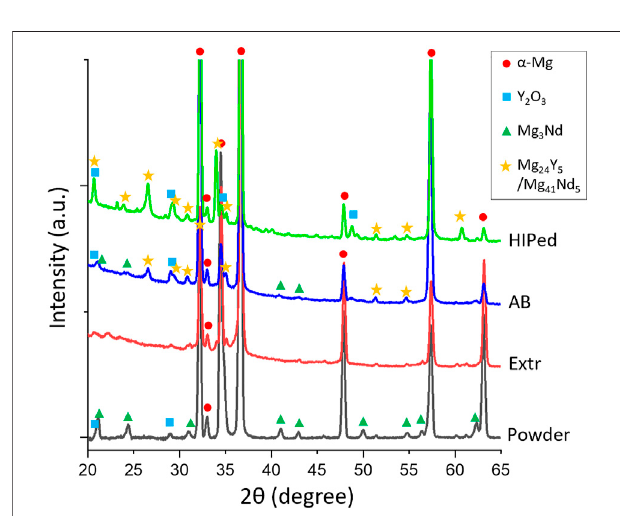
FIGURE 4 | XRD spectra of the powder, the Extr, AB and HIP